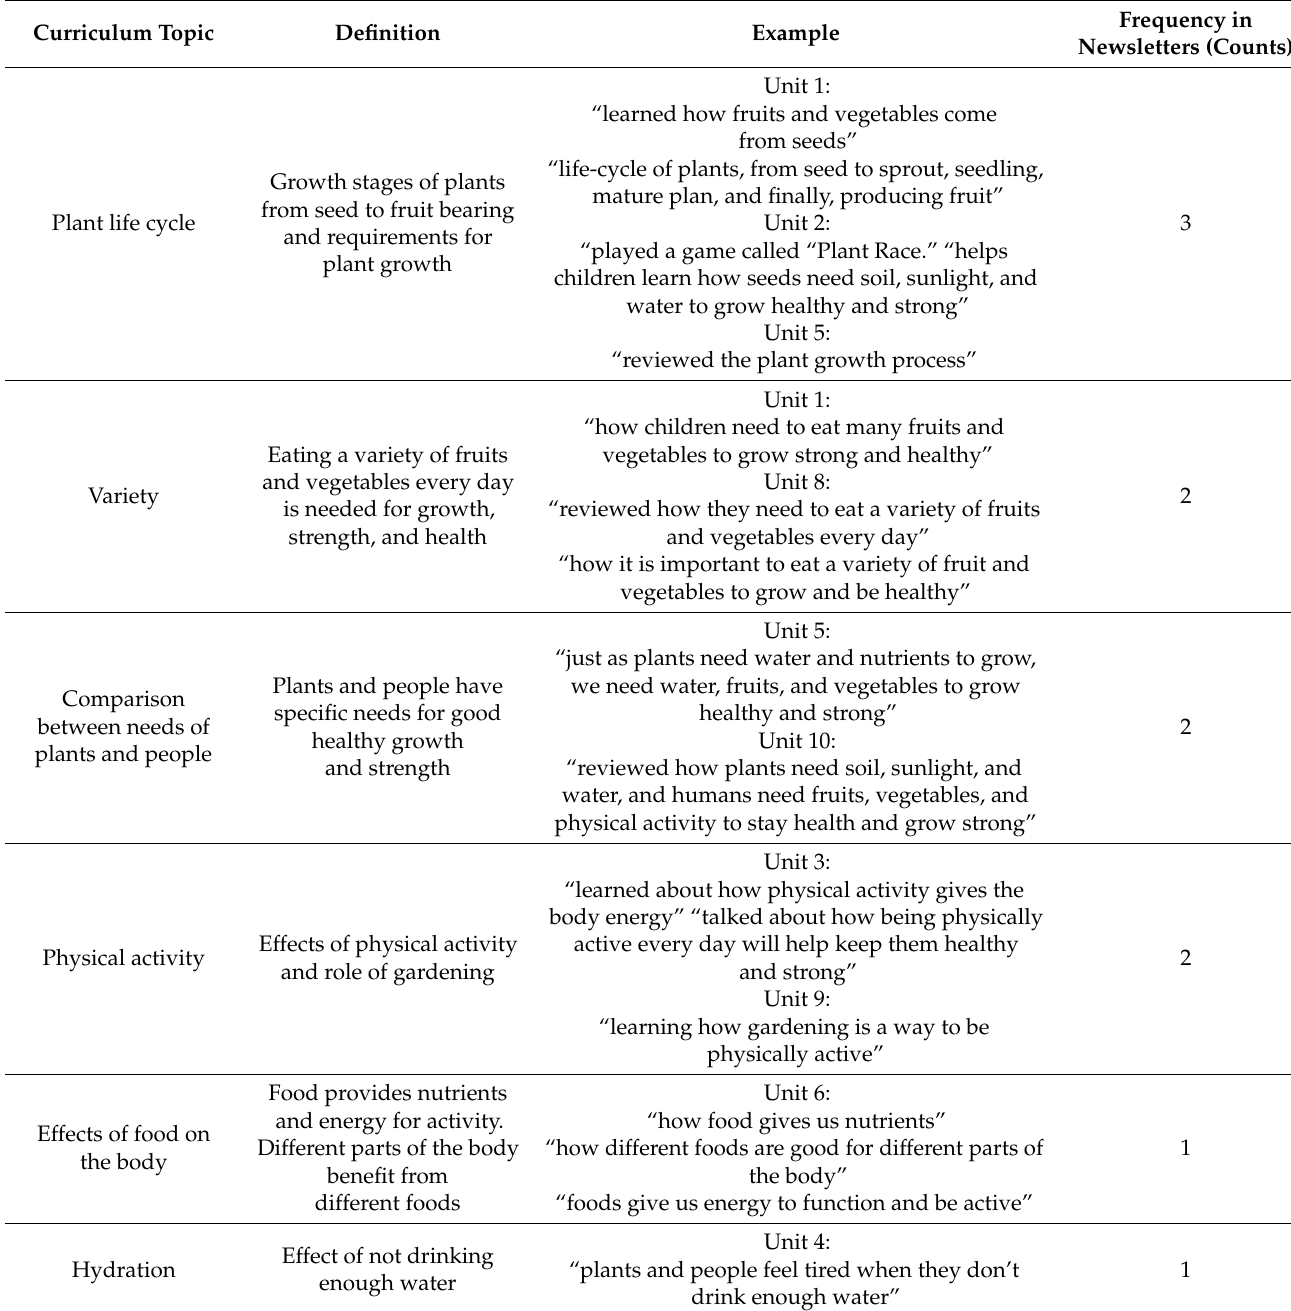
Table 4. Summary of SAGE curriculum topics included in